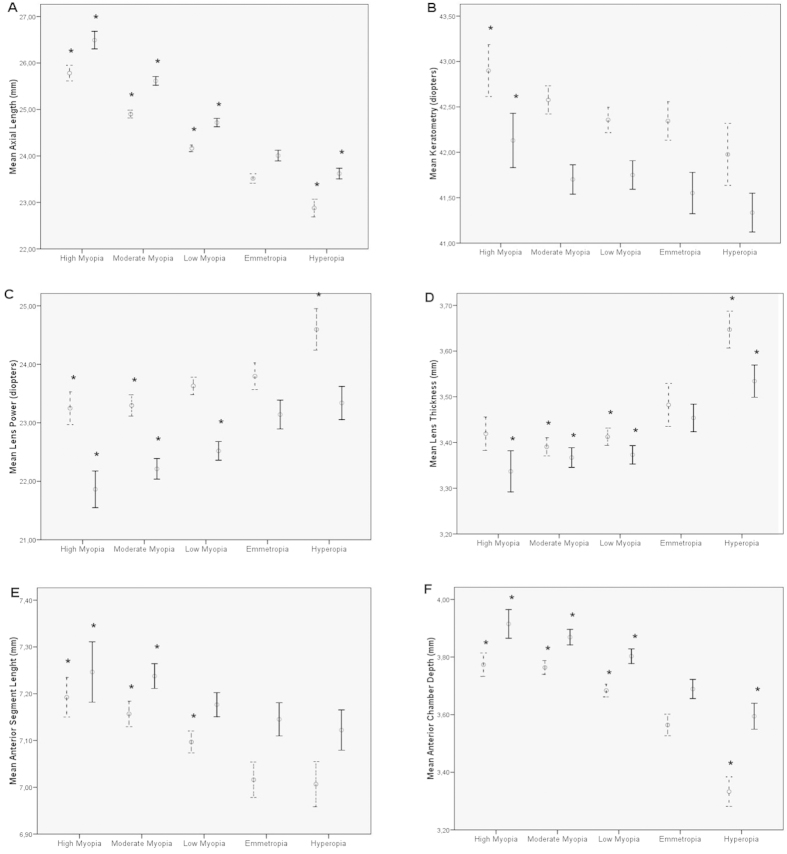
Mean ocular components and 95% confidence intervals for the different refractive error groups.Girls in doted lines, boys in full lines. The asteriscs (*) represent significant differences (p < 0.001) when the given group is compared to the emmetropic group of the same gender. The whiskers with the 95% confidence intervals also show the significance of the differences when they do not reach the mean of the group with which any given mean is compared.